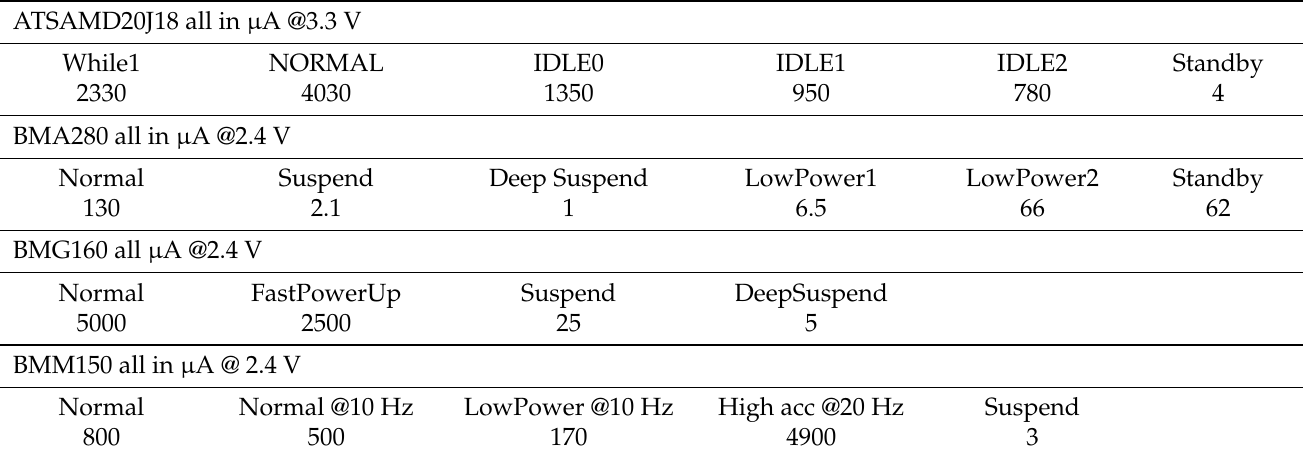
Table 1. Power values from data sheets.